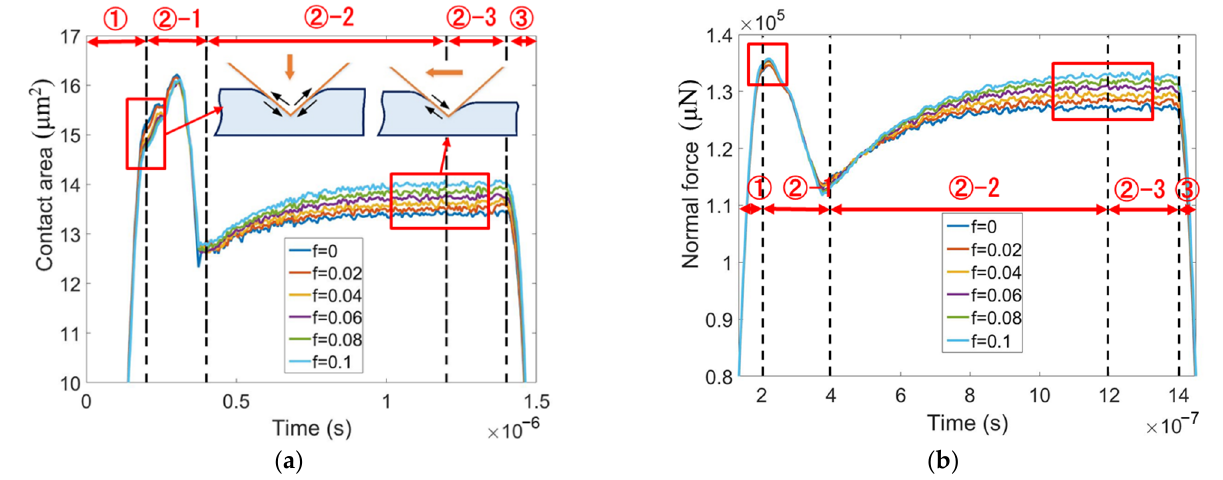
Figure 10. The evolutions of ( a ) contact area and ( b ) normal force with time at various friction coefficients for edge-leading Berkovich scratching.